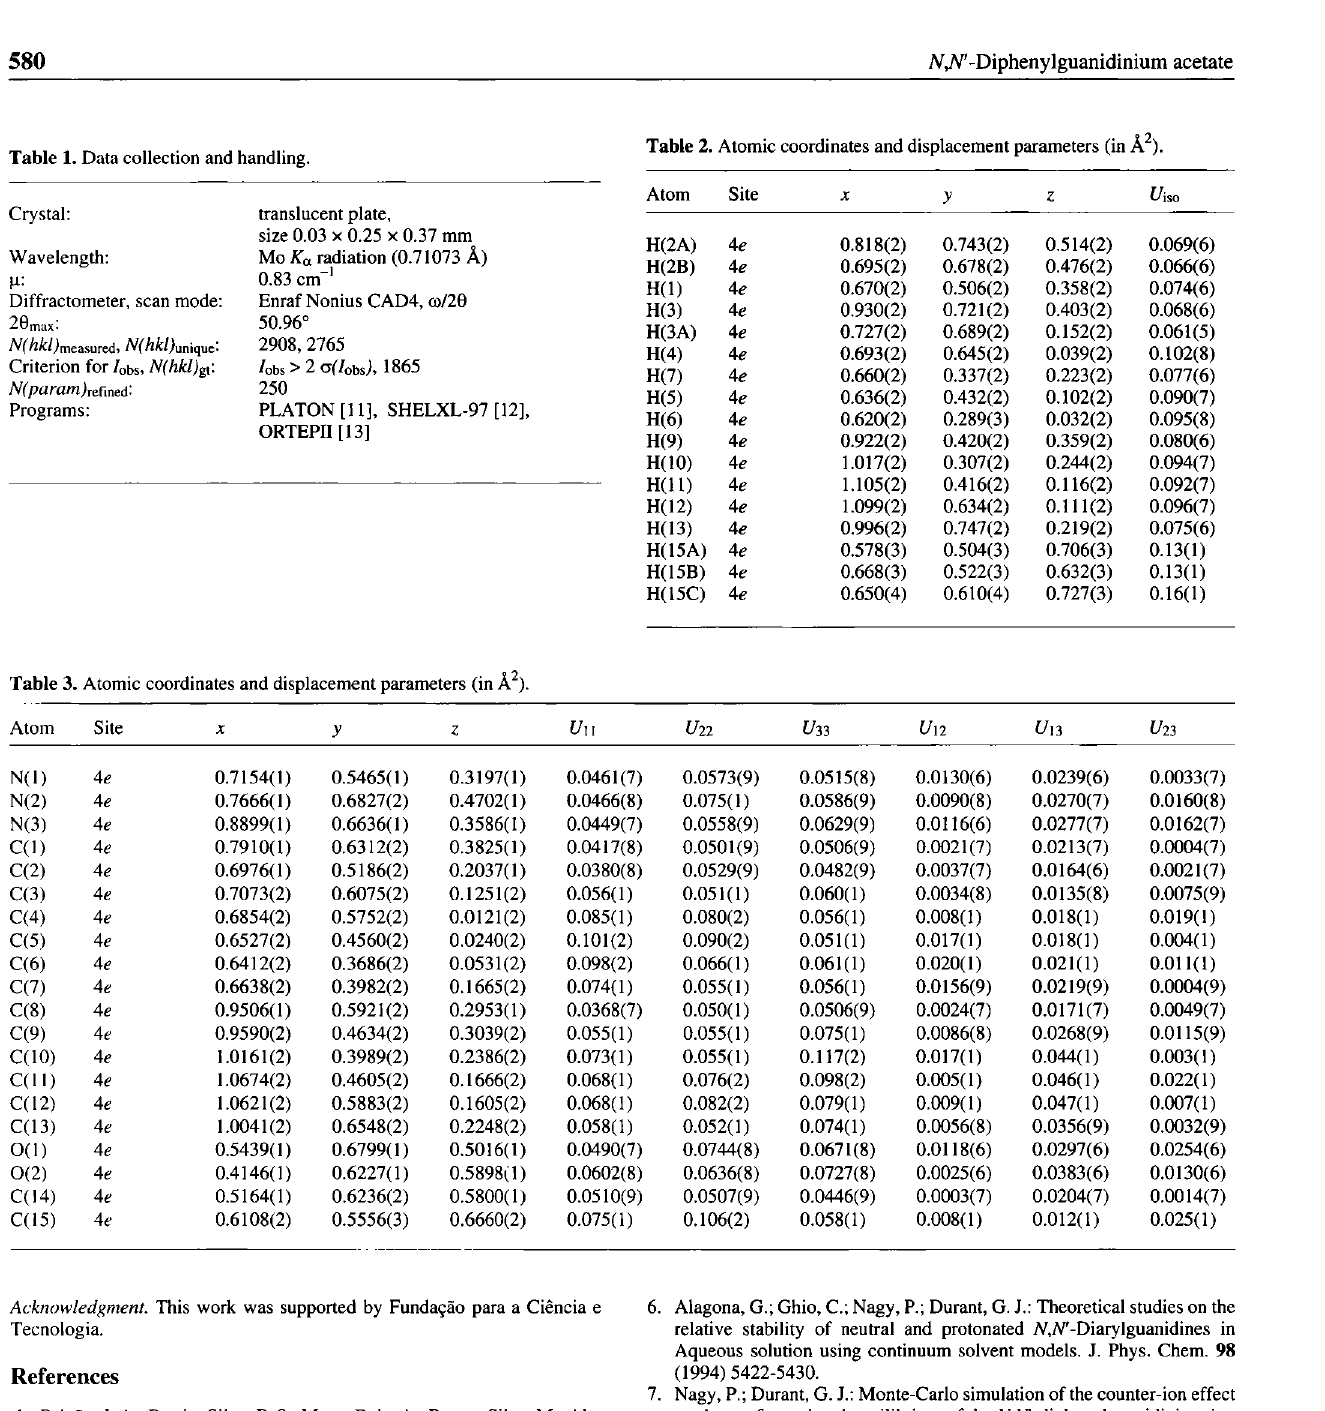
Table 1. Data collection and handling.